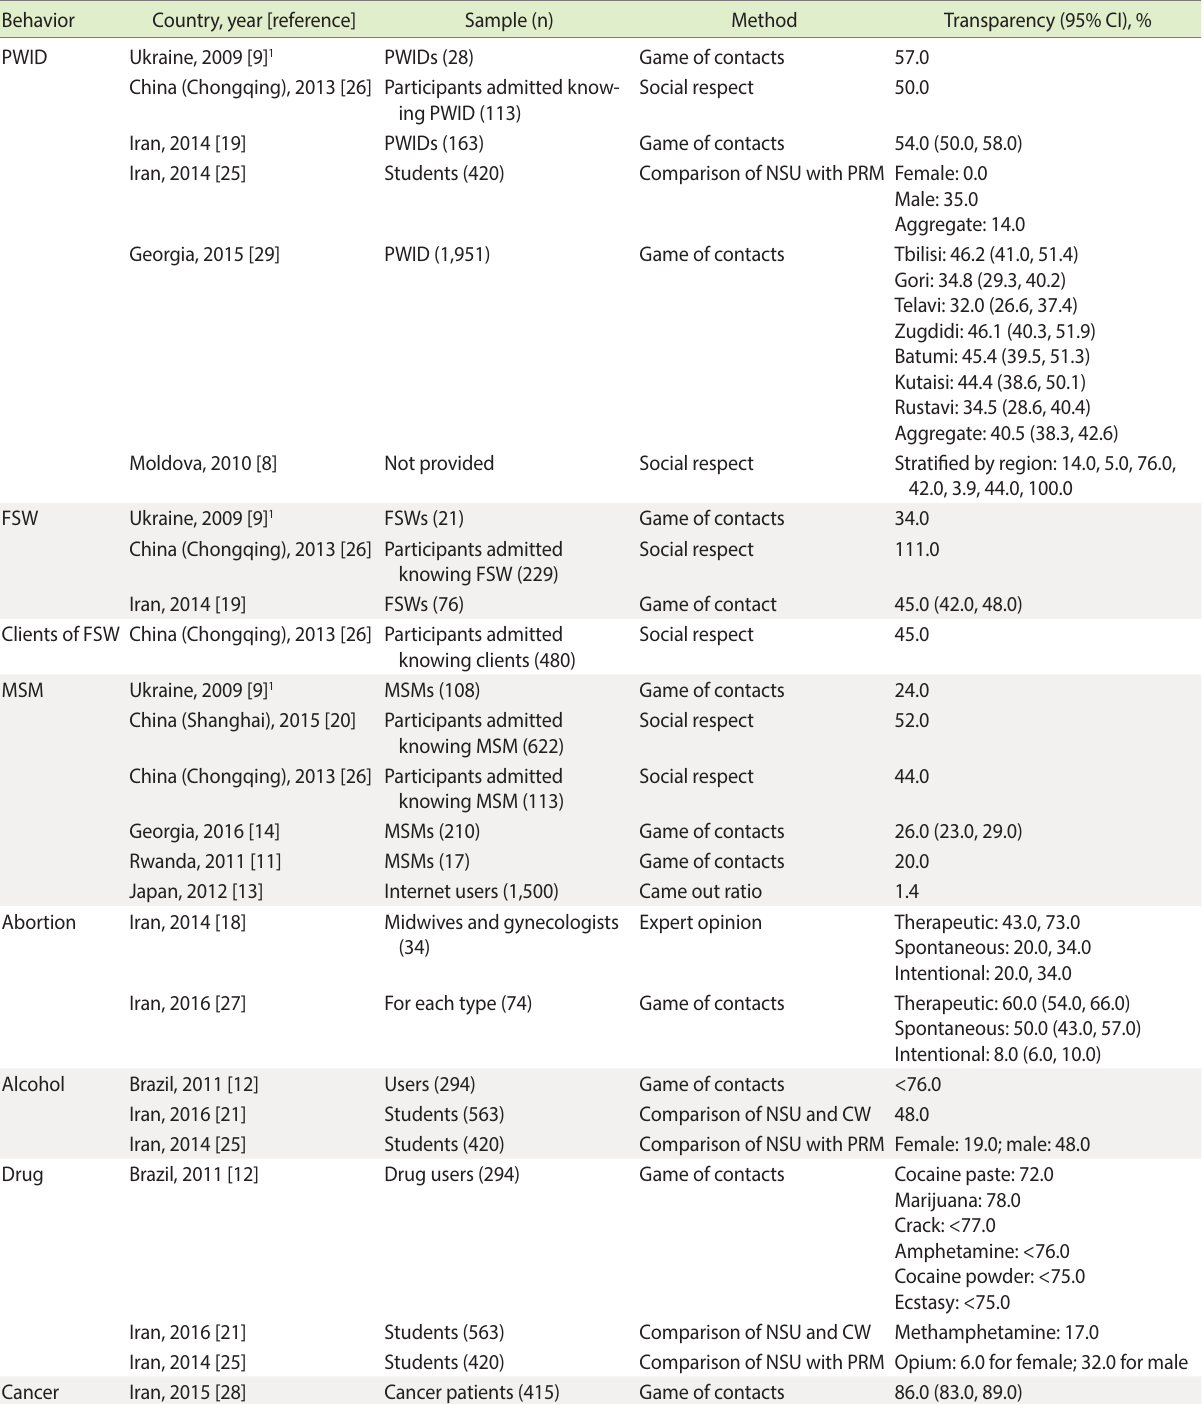
Table 2. Summary of studies that reported visibility factor Behavior